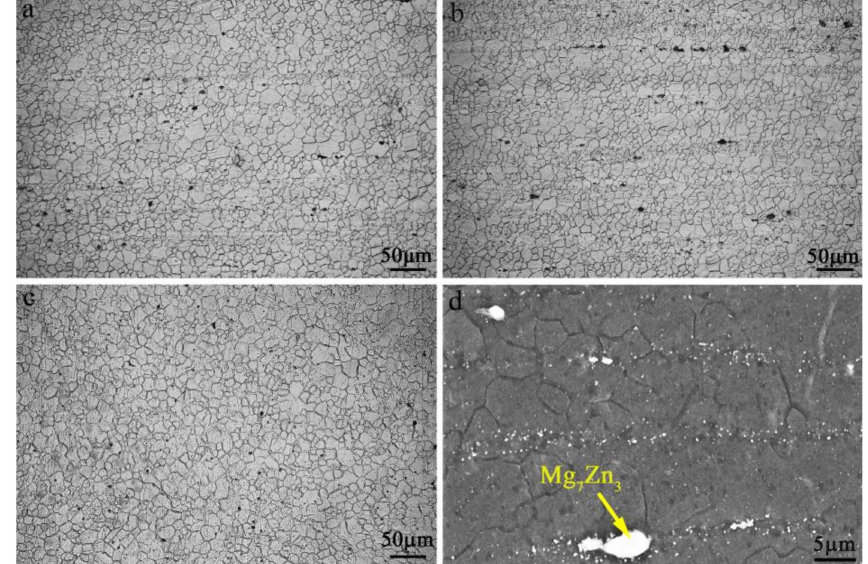
Figure 7. Optical images of the ( a ) longitudinal section, ( b ) outside surface and ( c ) cross section for the as-extruded ZM51 alloy tube, and ( d ) SEM image of the outside surface of the as-extruded ZM51 alloy